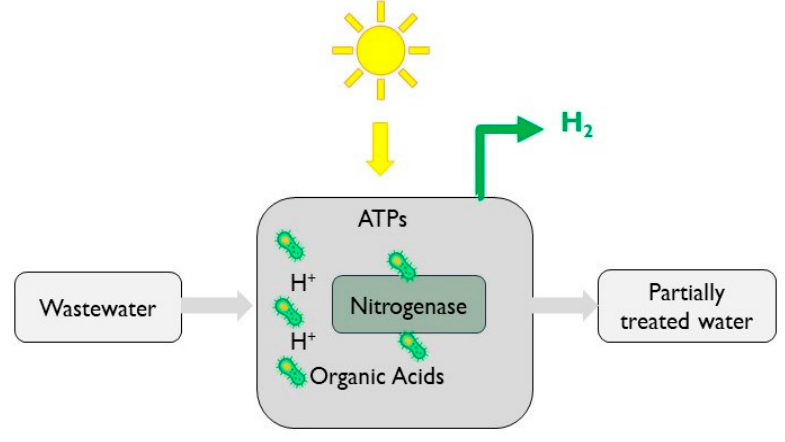
Figure 4. Schematic diagram of photo-fermentation process.